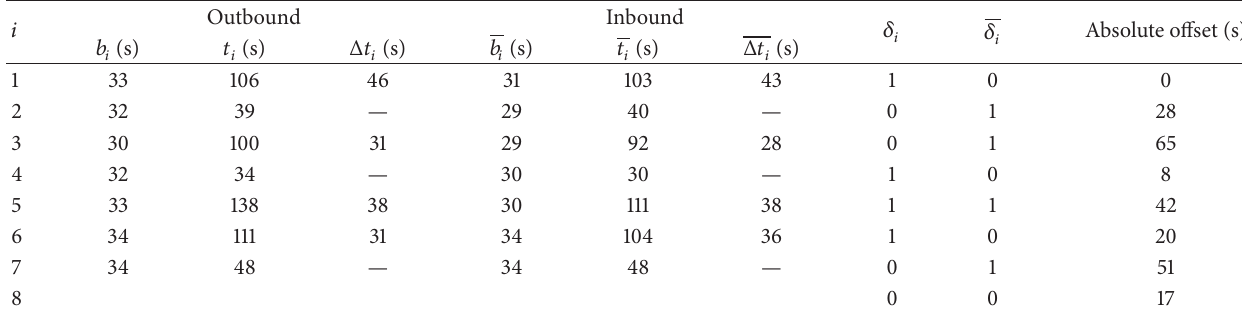
Figure 6: Time-space diagrams of green band from BAM-TRAMBAND. Table 3: Results from